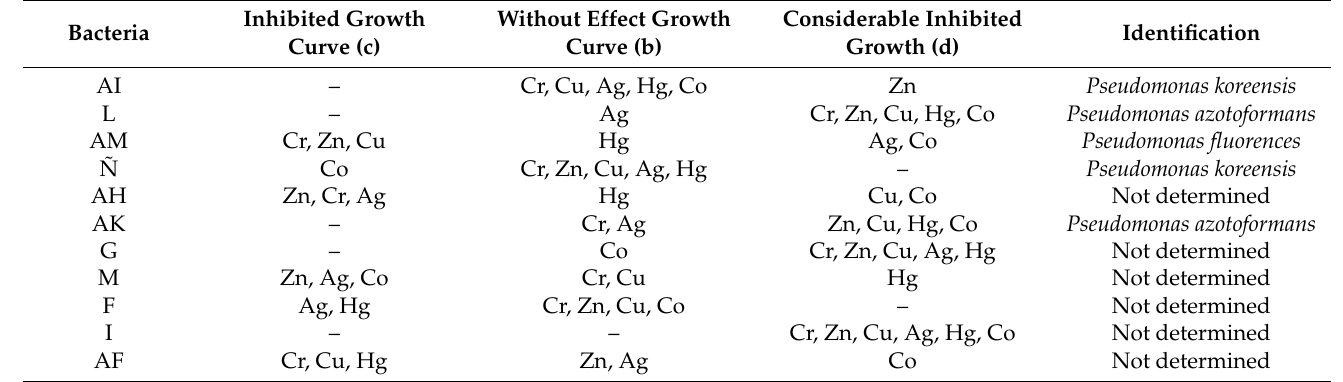
Table 5. Type of behavior for each bacterium tested in presence of heavy metals.